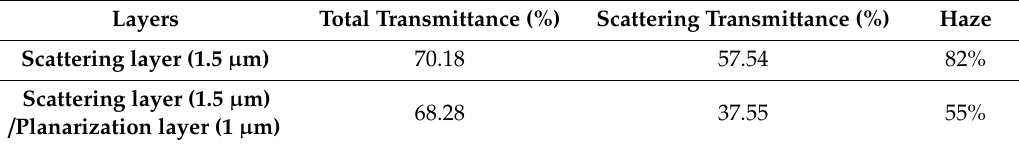
Table 1. Transmittance and haze of the TiO 2 nanoparticle scattering layer.